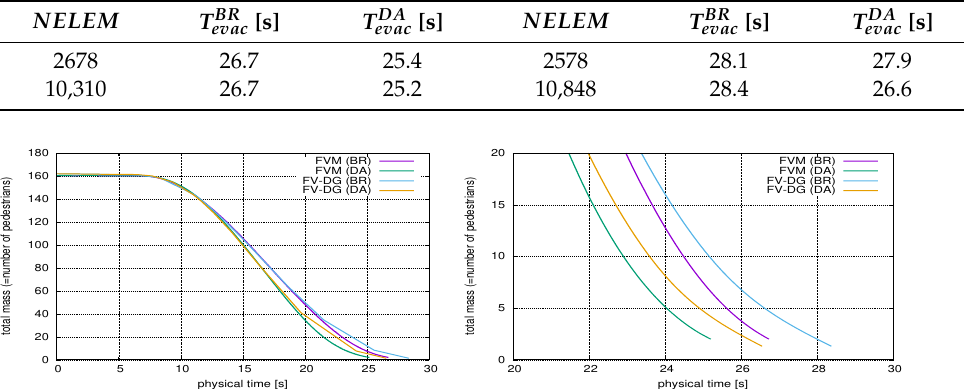
Figure 10. T-shape domain, the time evolution of the total number of pedestrians M ( t m ) for the finest grid # T h = 10,310 (FVM) and # T h = 10,848 (FV-DG), total view ( left ) and the detailed view close to the end of the evacuation ( right